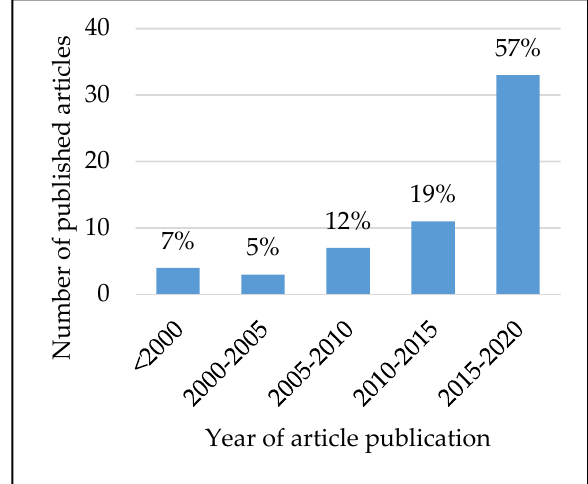
Figure 1. Article publication over time for web-based orthopedic predictive tools.